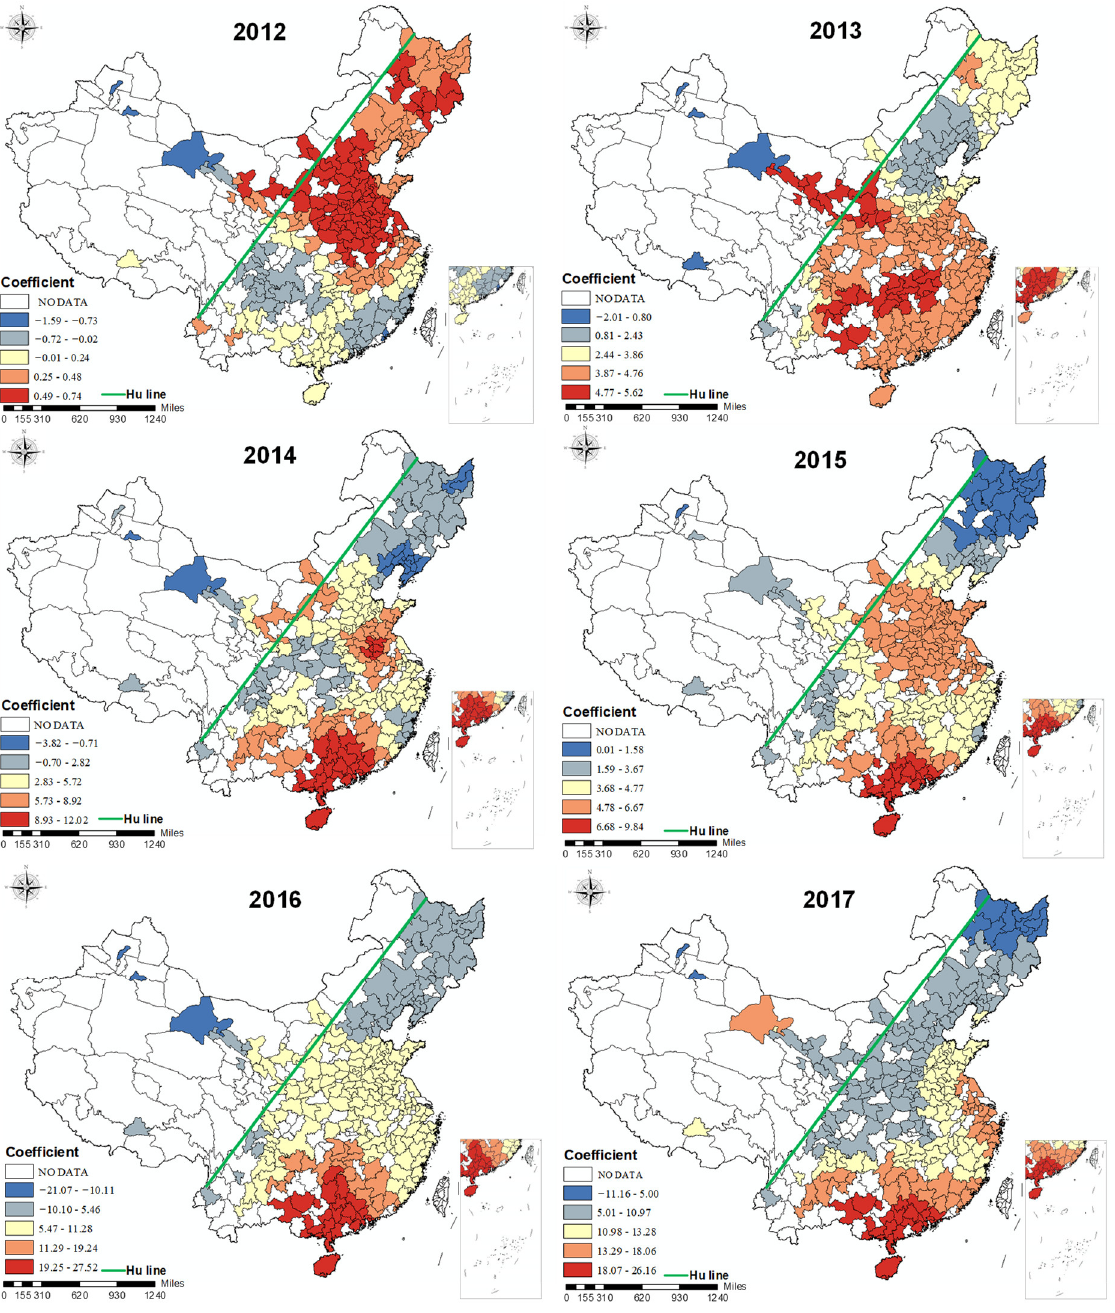
Figure 5. The spatial coefficient distribution for science and technology personnel from 2012 to 2017 based on the GWR model. (Note: A positive coefficient means a positive association between an increasing proportion of science and technology personnel (N_SNTP) and more inferiority, while the negative coefficient is the opposite.).